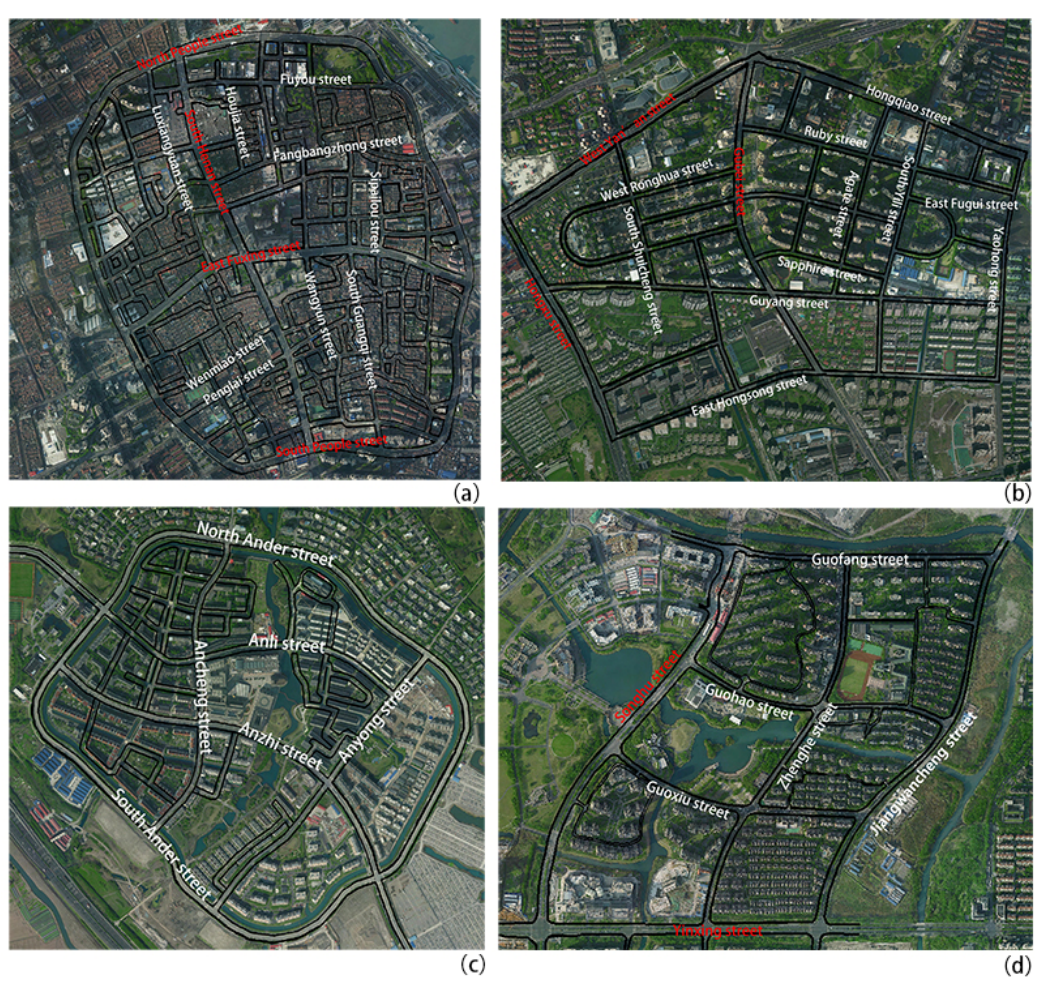
Figure 1. Satellite image and the streets fabric network of the four areas in 2017. ( a ) Old downtown zone, ( b ) Gubei international community, ( c ) Anting New Town zone (1.05 km 2 ), ( d ) New Jiangwan Town zone (1.31 km 2 ); Red fonts represent the urban main road; White fonts represent the branch road. Source: https://earth.google.com/web/.